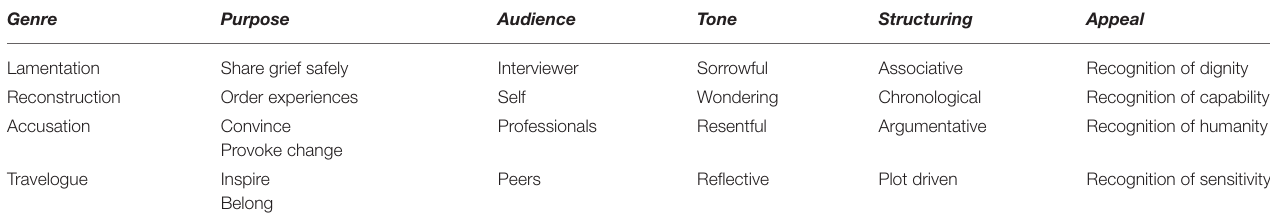
TABLE 4 | Synthesis of results on the interpersonal level.